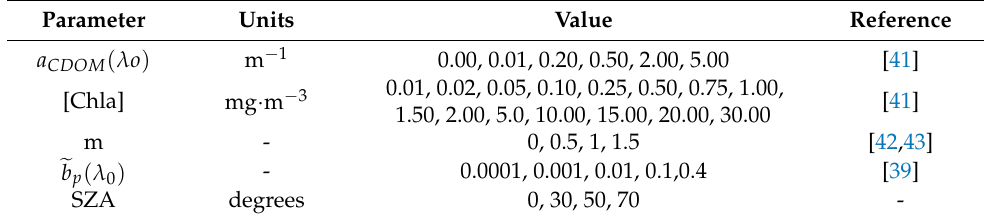
Table 1. Variation of optically active constituent (OAC) parameters used in HL to simulate the 7200 spectra of Rrs − SICF . The range of values for each parameter was taken according to values known in the literature (see column